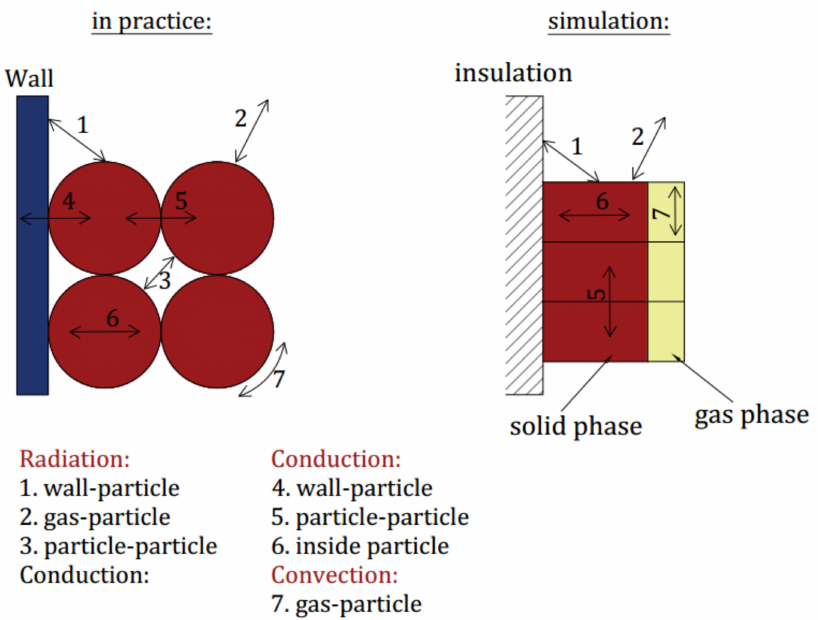
Figure 1. Heat transfer mechanisms in packed bed and continuous medium modeling.